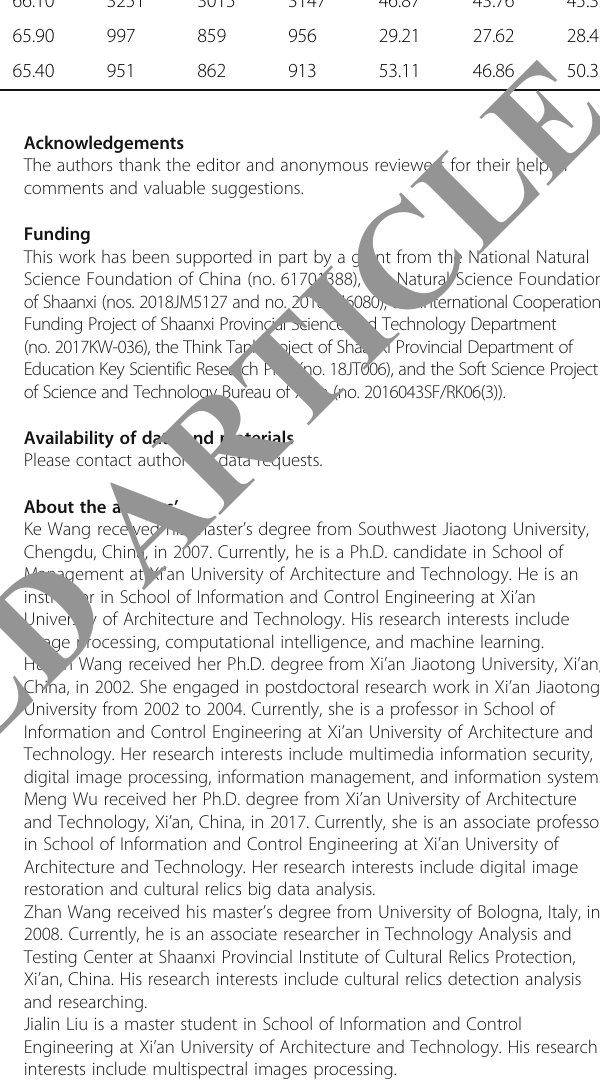
Table 2 Comparison of registration results of T-SURF 、 CD-SURF, and MSM-SURF Method RMSE T-SURF CD-SURF